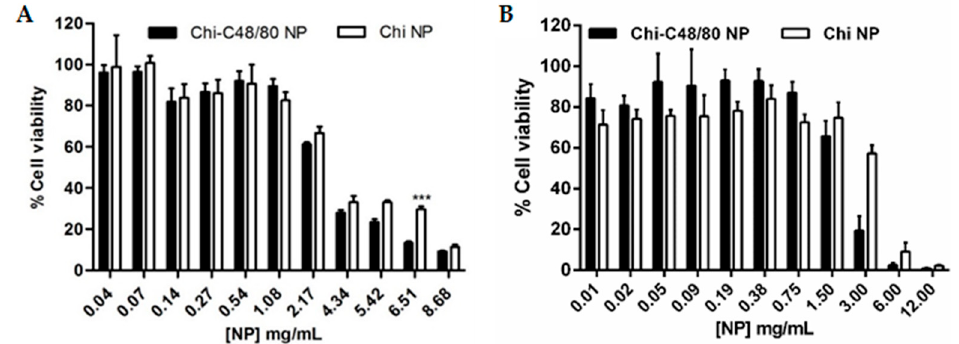
Figure 7. Effect of Chi-C48/80 NPs and Chi NPs on viability of spleen cells ( A ) and epithelial A549 cells ( B ). Different concentrations of nanoparticles were incubated with cells for 24 h. The cell viability was measured by MTT assay. Each result is representative of two independent experiments performed in quadruplicate for spleen cells and three independent experiments performed in quadruplicate for A549 cells (mean ± SD).